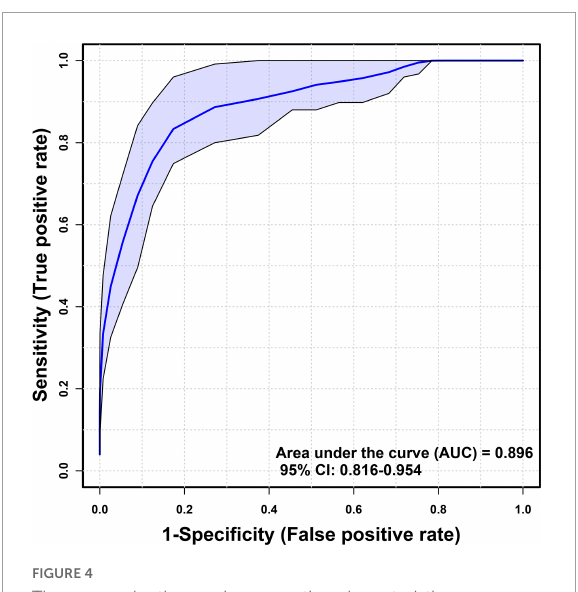
FIGURE4 The area under the receiver operating characteristic curve performance for